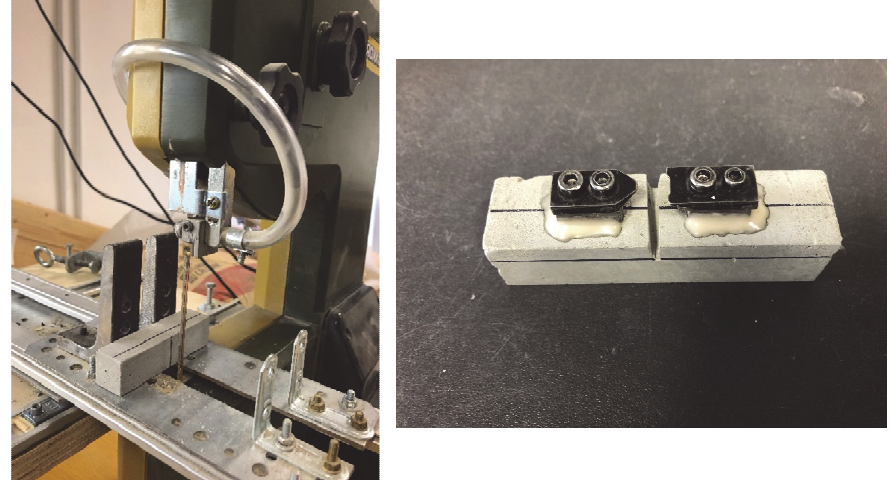
Figure 2: Realization of the notch with band saw (left) and detail on the bonding of the clip-on strain gauge on the two sides of the notch